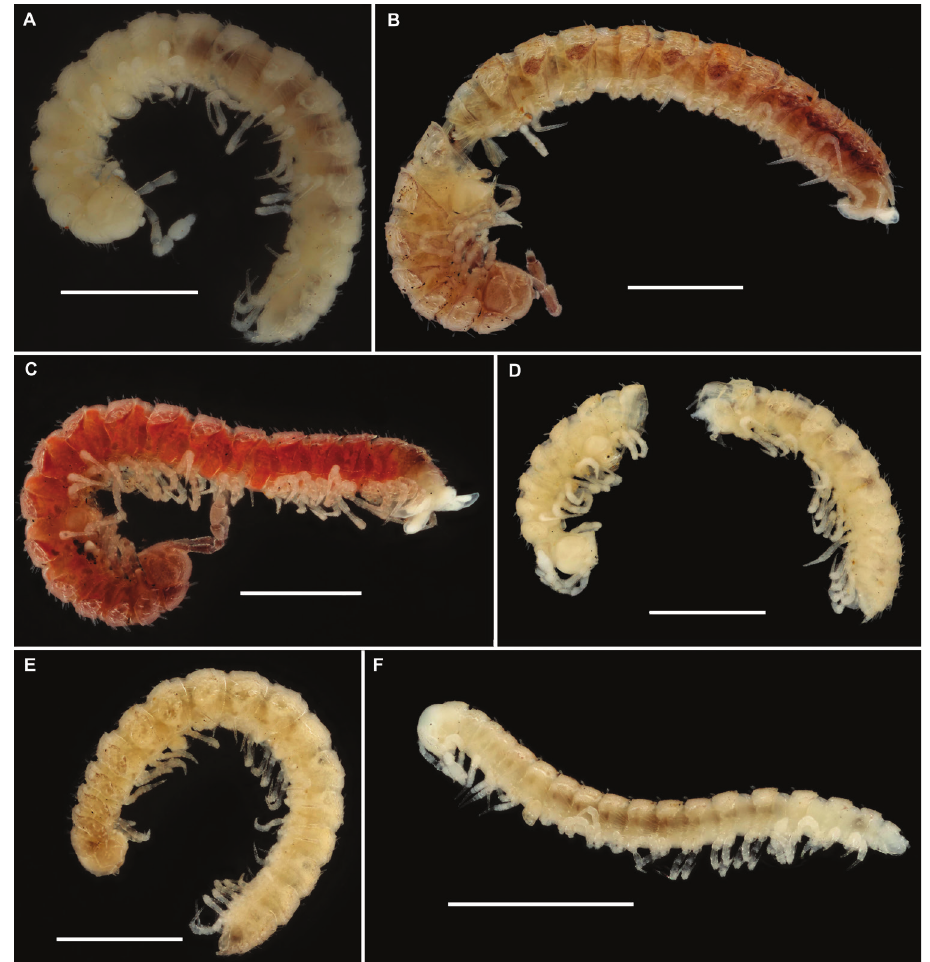
Figure 28. Habitus of Hemisphaeroparia species in lateral view, holotypes of H. zamakoe sp. n. ( A ), H. bangoulap sp. n. ( B ), H. spiniger sp. n. ( C ), H. ongot sp. n. ( D ), H. digitifer sp. n. ( E ) and H. parva sp. n. ( F